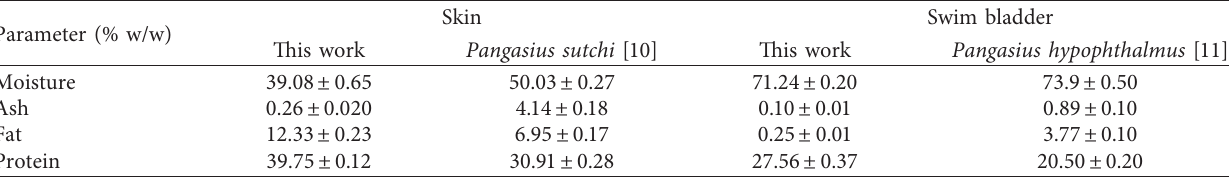
Table 1: Proximate analysis of Pangasius waste materials.